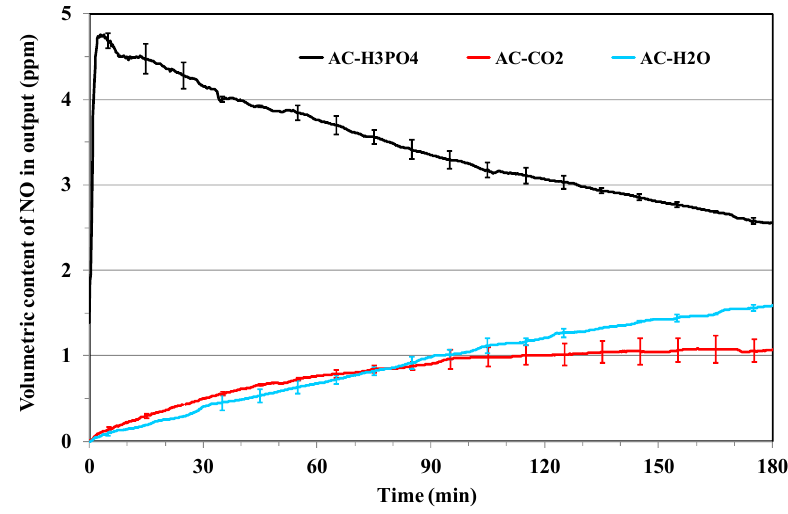
Figure 8. Breakthrough curves of NO through three differently activated sorbent samples made from olive stones (c 1 NO 2 = 5 ppm, c 1 NO = 0 ppm, 23 °C, 50% RH, v = 0.2 m/s, m Sorb = 2 g).